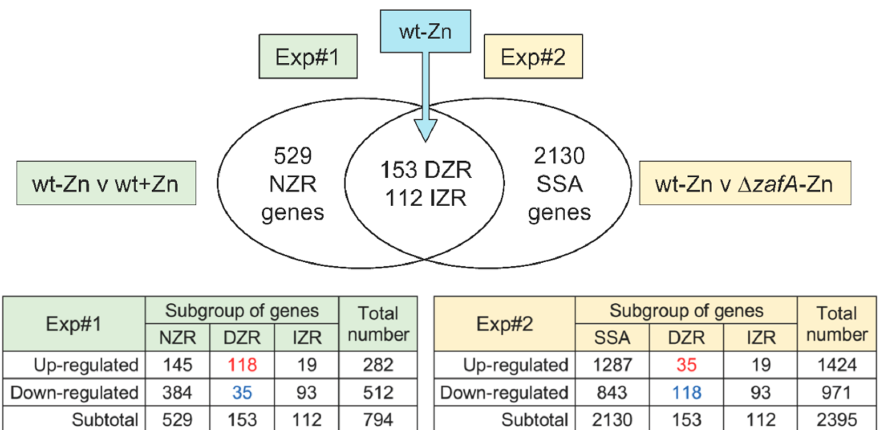
Figure 2. Quantitative summary of different types of genes detected in microarray experiments. SSA: strain-specific adapted (genes); DZR: directly ZafA regulated; IZR: indirectly ZafA regulated ; NZR: non-ZafA regulated.